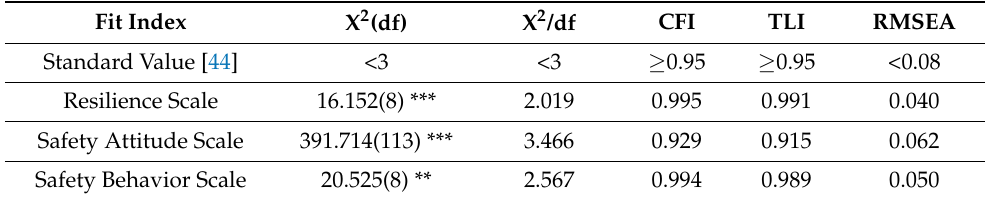
Table 3. The result of the